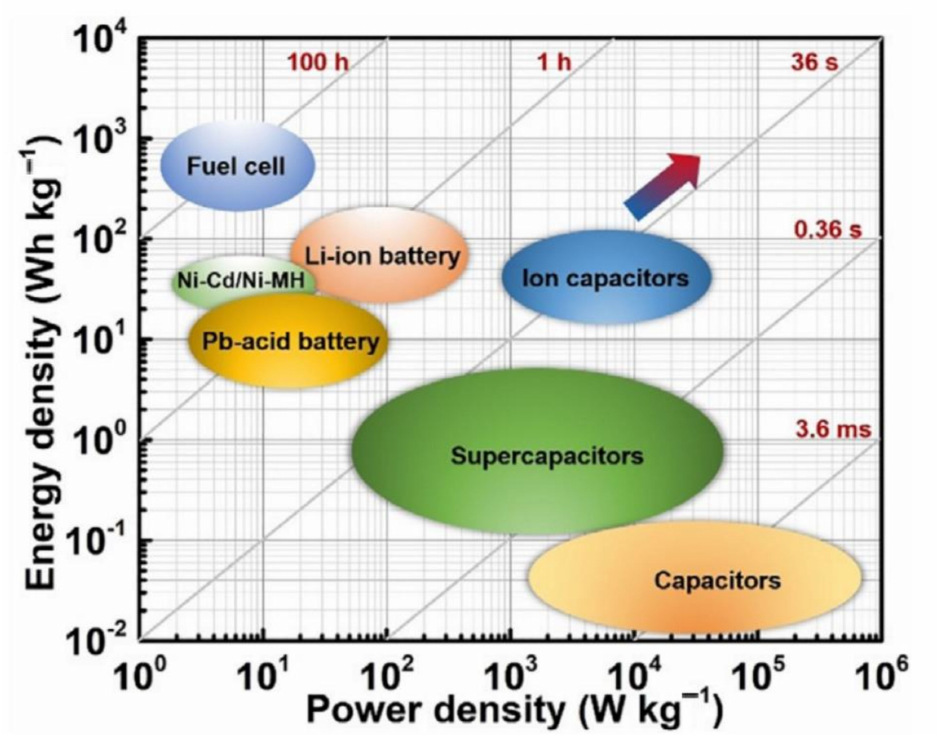
Figure 8. The comparison of energy density and power density for different energy storage de- vices